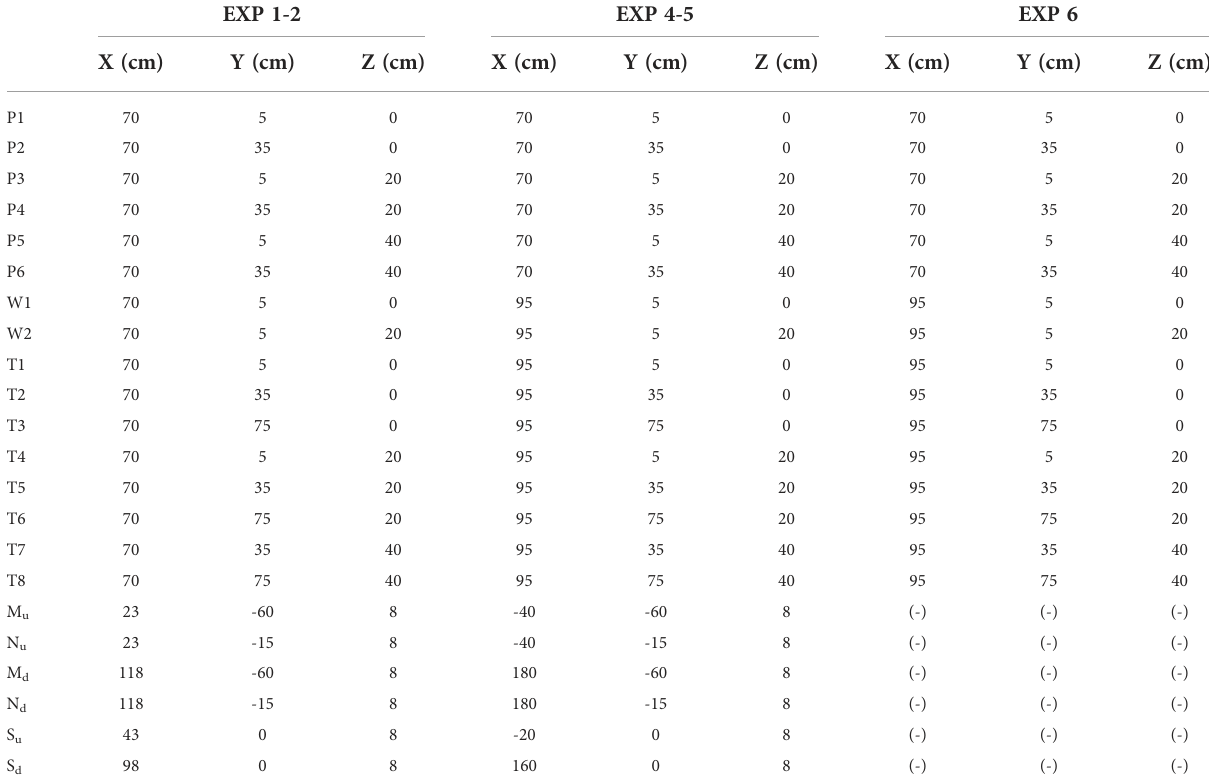
TABLE 3 Planimetric and vertical positions of tensiometers, stress, and soil moisture sensors, fl ow velocity probes, and OBSs during the six